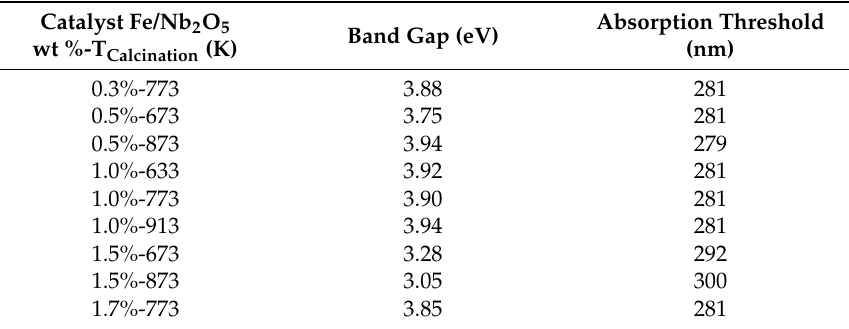
Table 2. Result of band gaps